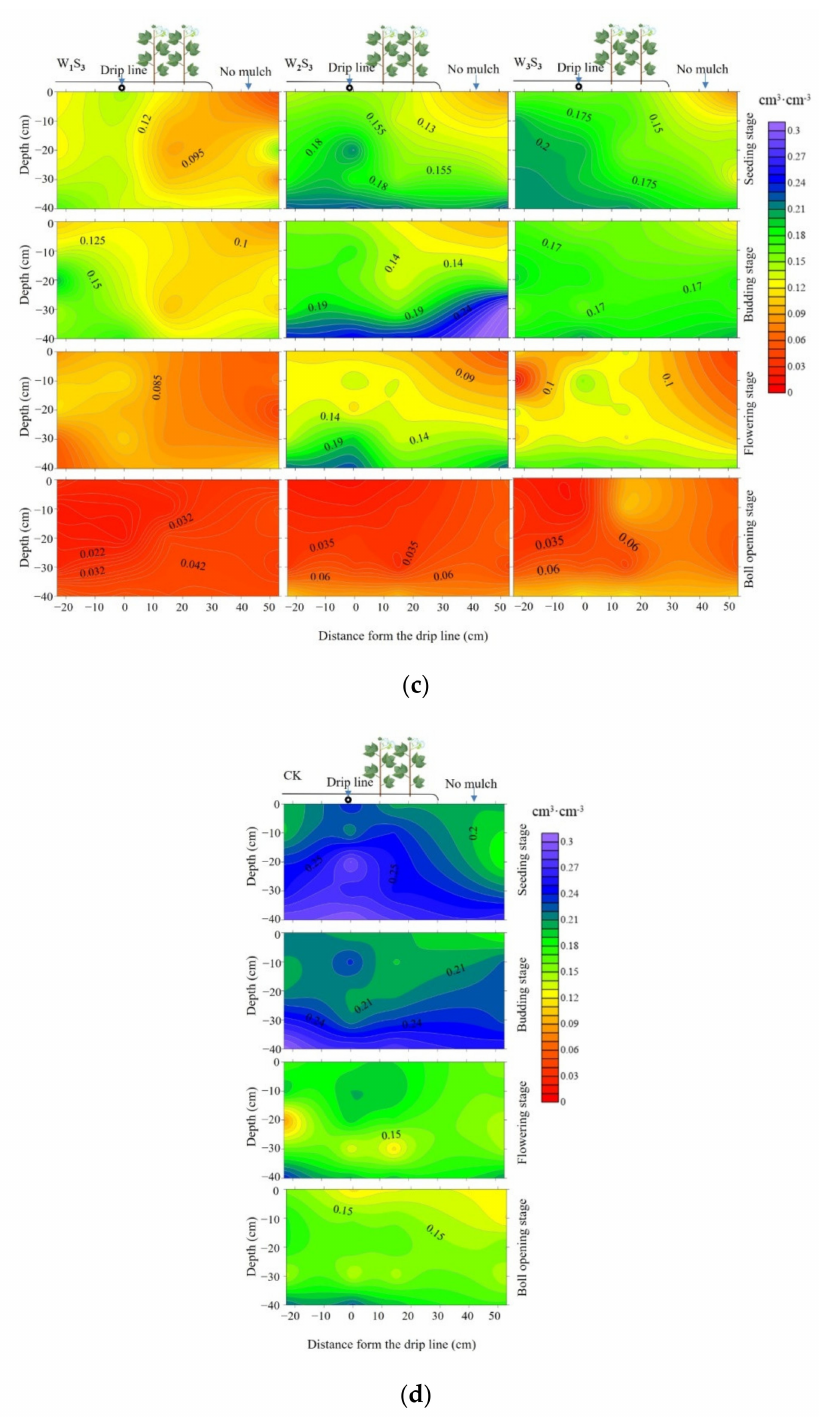
Figure 3. Dynamic changes in soil moisture content in 0–40 cm soil layer of each treatment. ( a ) ir- rigation application at the seeding stage; ( b ) irrigation application at the seeding stage + budding stage; ( c ) irrigation application at the seeding stage + budding stage + flowing stage; ( d ) no irrigation application